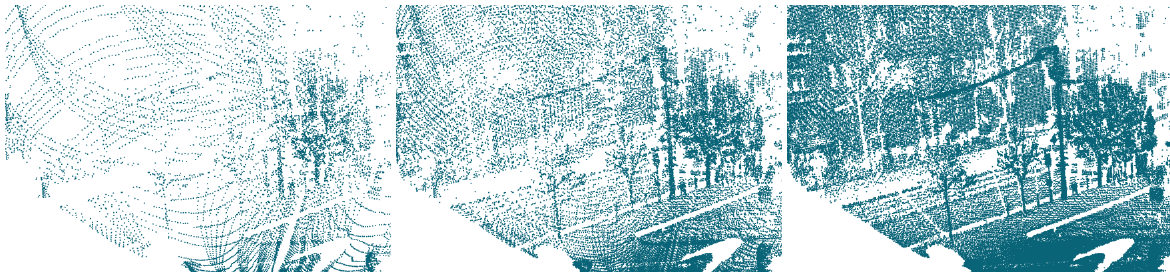
Figure 7. Evolution of the high-resolution background model in the City Center